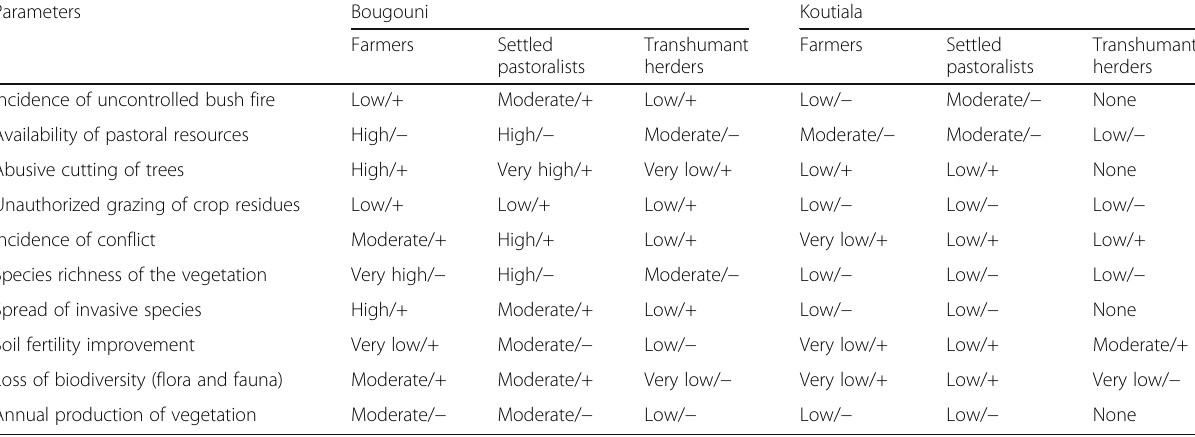
Table 4 Perceived magnitude of impact of transhumant practices on NRM in southern Mali Parameters